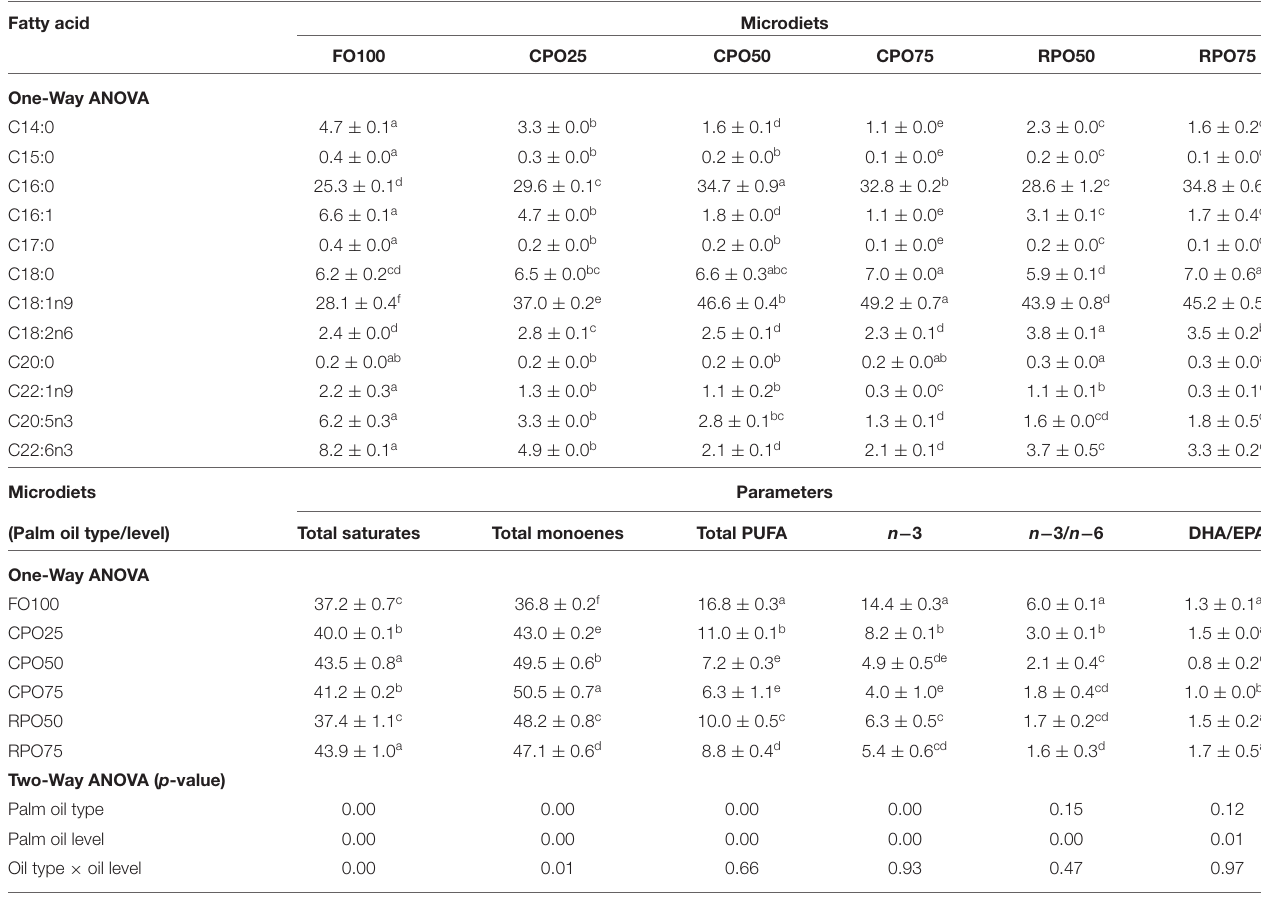
TABLE 6 | Fatty acid composition (% of total fatty acids) in fish body fed different microdiets. Fatty acid Microdiets FO100 One-Way